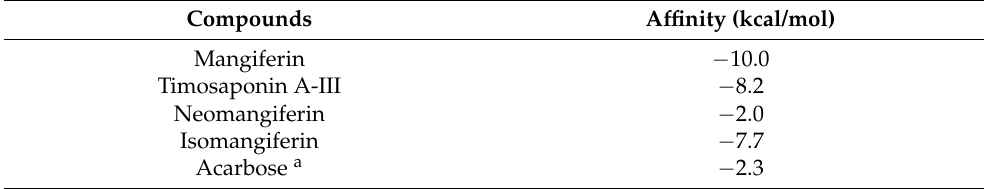
Table 9. Binding energies of active components and acarbose calculated in silico. Compounds Affinity (kcal/mol) Mangiferin − 10.0 Timosaponin A-III − 8.2